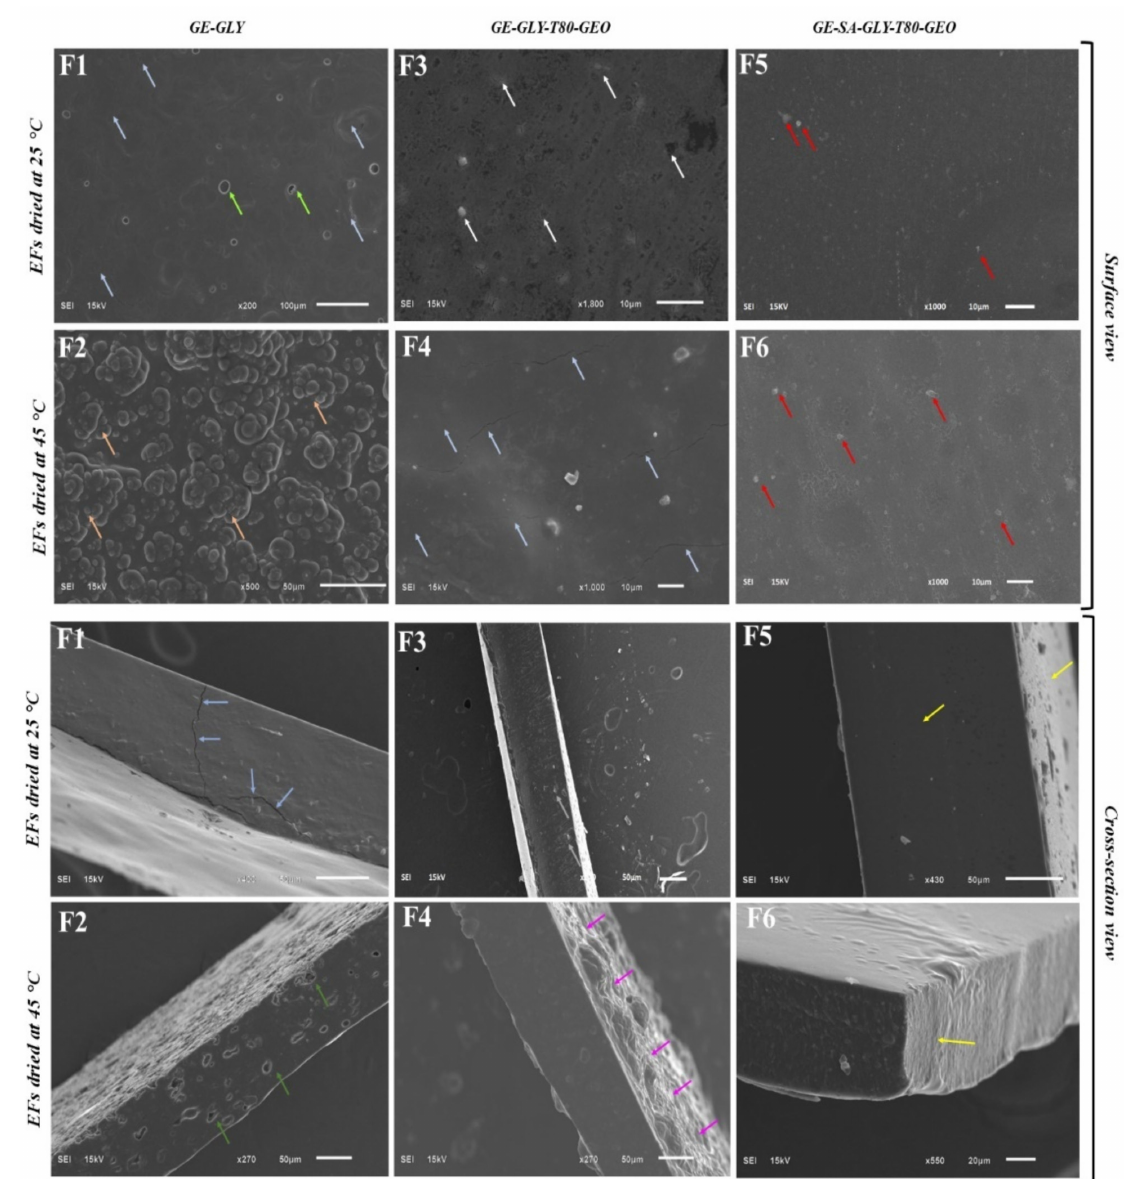
Figure 1. SEM images (both surface and cross-section) of GE based film with and without SA. ( F1 ): GE-Gly, dried at 25 ◦ C, ( F2 ): GE-Gly, dried at 45 ◦ C, ( F3 ): GE-Gly-T80-GEO, dried at 25 ◦ C, ( F4 ): GE-Gly-T80-GEO, dried at 45 ◦ C, ( F5 ): GE-SA-Gly-T80-GEO, dried at 25 ◦ C, ( F6 ): GE-SA- Gly-T80-GEO, dried at 45 ◦ C. The blue color indicates the cracks, orange color represents surface roughness, white color shows tricuspid shaped cracks, red color represents particles at the surface, deep green color indicates pores, pink color represents surface bulges, and yellow color indicates smoothness at cross-sectional